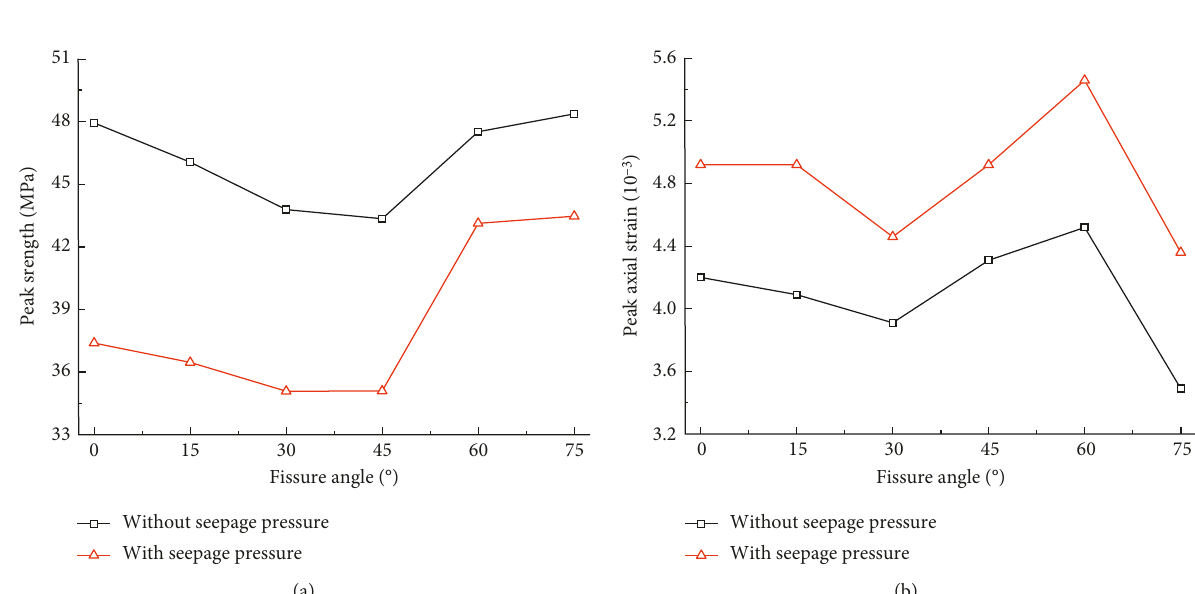
Figure 3: Effect of the fissure angle on the strength and deformation parameters for the sandstone specimens containing flaws. (a) Relationship between peak strength and fissure angle. (b) Relationship between peak axial strain and fissure